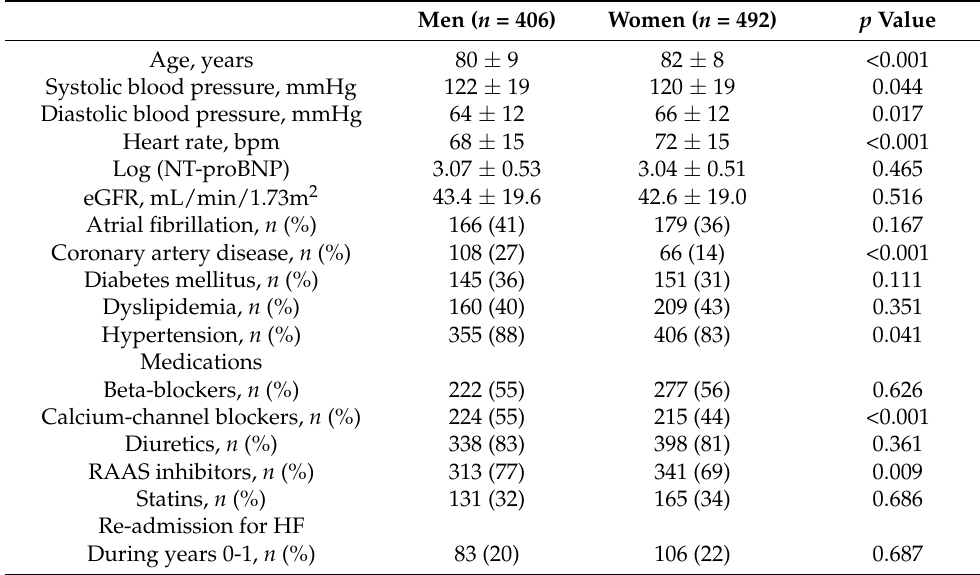
Table 1. Between-sex differences in patient characteristics before discharge and event rates. Men ( n =